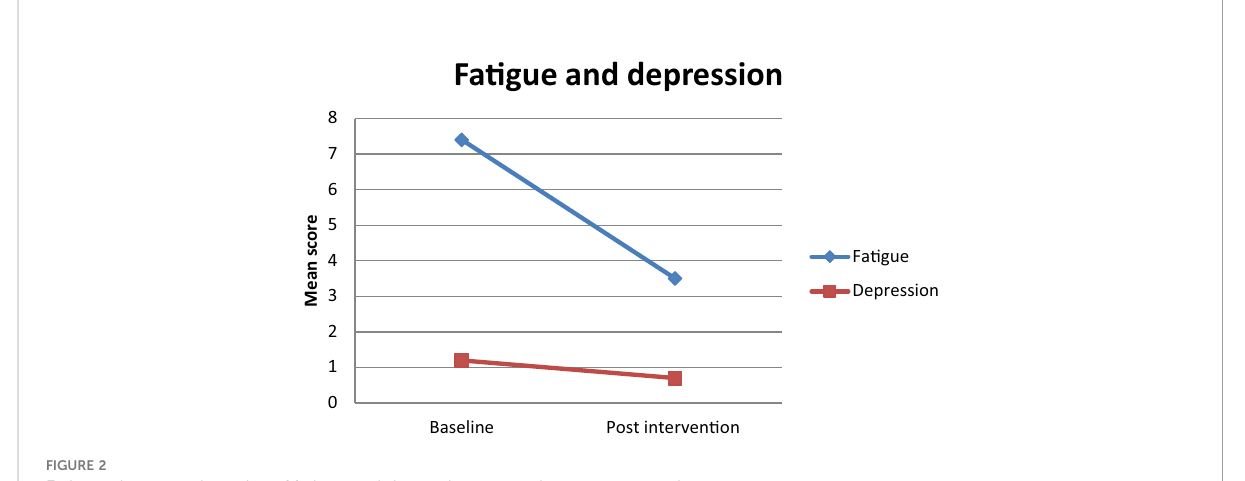
FIGURE 2 Estimated mean trajectories of fatigue and depression among breast cancer